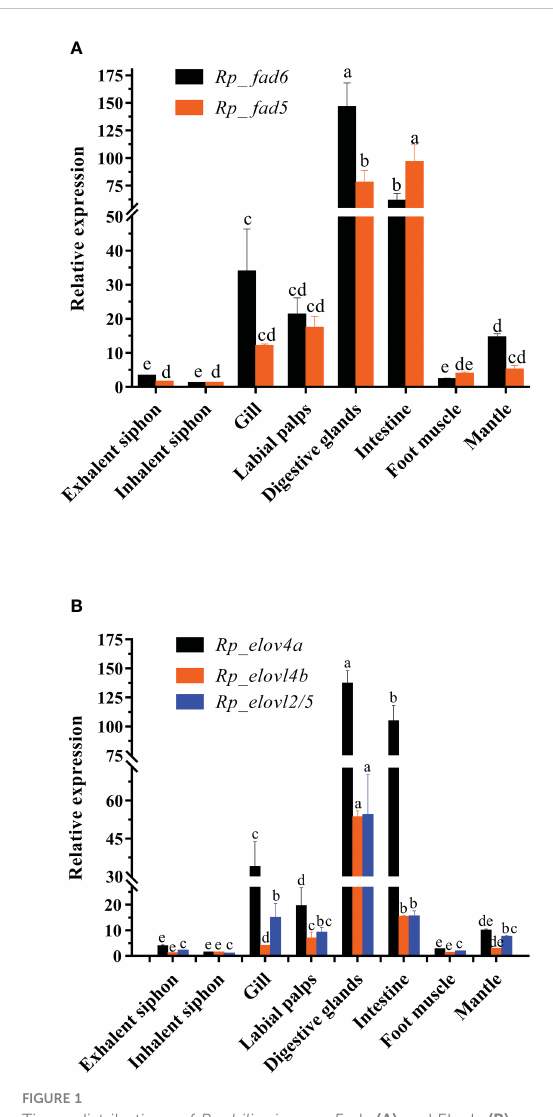
FIGURE 1 Tissue distributions of R. philippinarum Fads (A) and Elovls (B) . Relative expression of those genes was measured by qRT-PCR, normalized by b -actin, and calibrated by that of inhalent siphon, respectively. Values sharing the common letters on the top of the same color columns are not signi fi cantly different ( P ≥ 0.05).